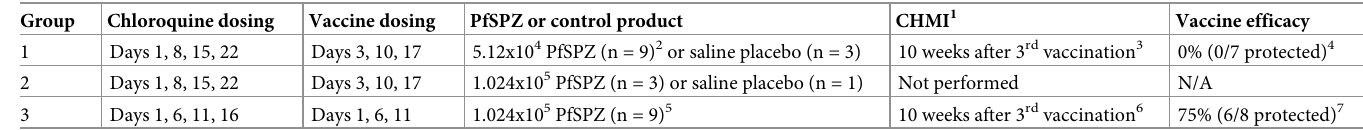
Table 1. Study groups, schedules, study products, and vaccine